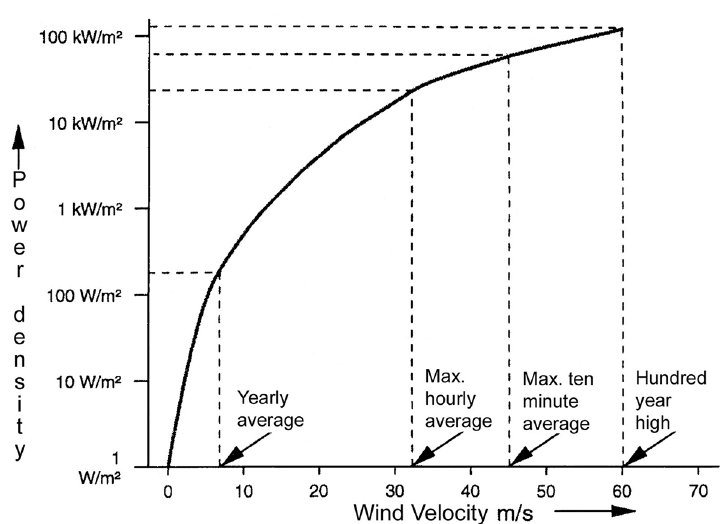
Fig. 2. – Relationship between wind velocity and power output (yearly average valid for Ger- many). Figure taken from